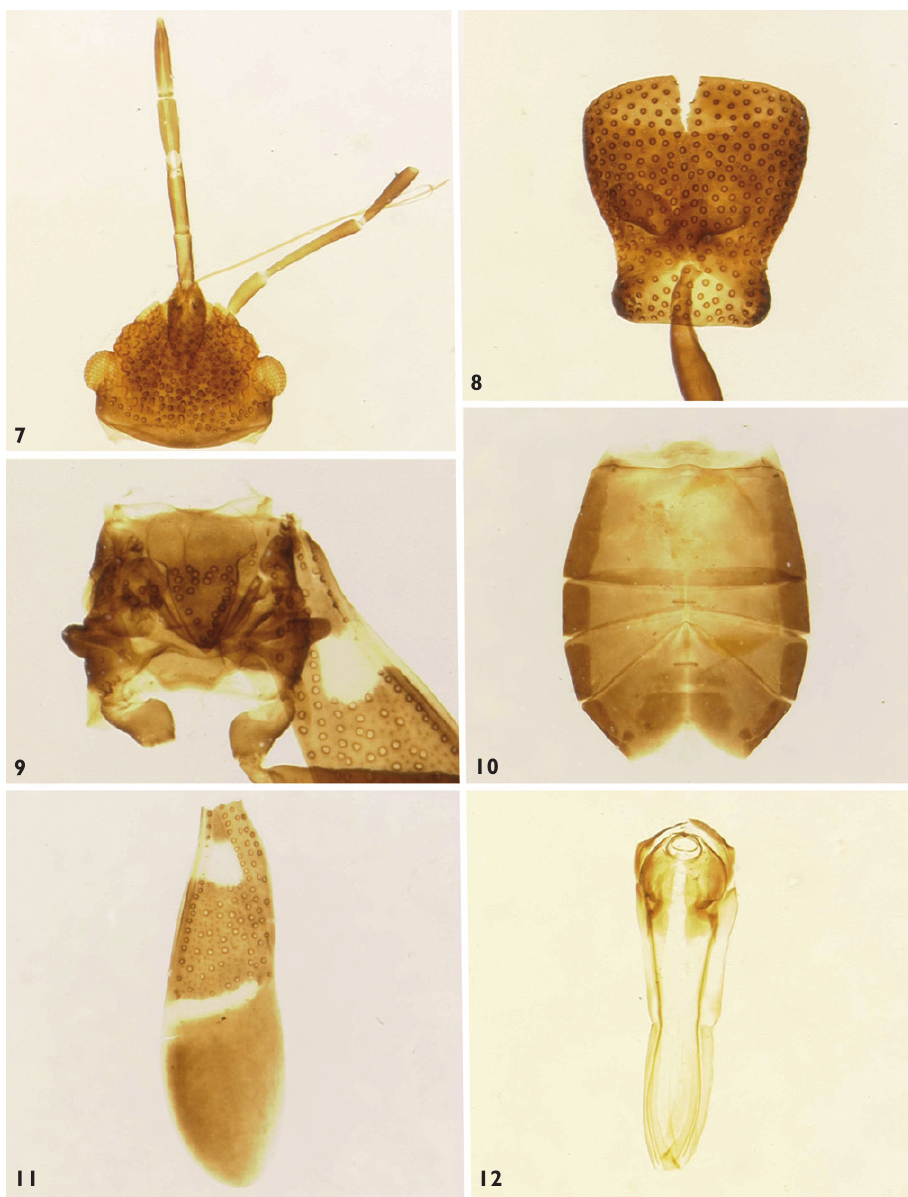
Figures 7–12. Notocoderus argentinus , paratype female (slide mounted) 7 Head 8 Pronotum 9 Th orax, including scutellum and ostiolar tuberculate tubercles 10 Abdomen 11 Hemelytron 12 Ovipositor. without veins, exceeding apex of abdomen. Hemelytron length to apex of membrane 1.58 mm, length to apex of corium 0.99